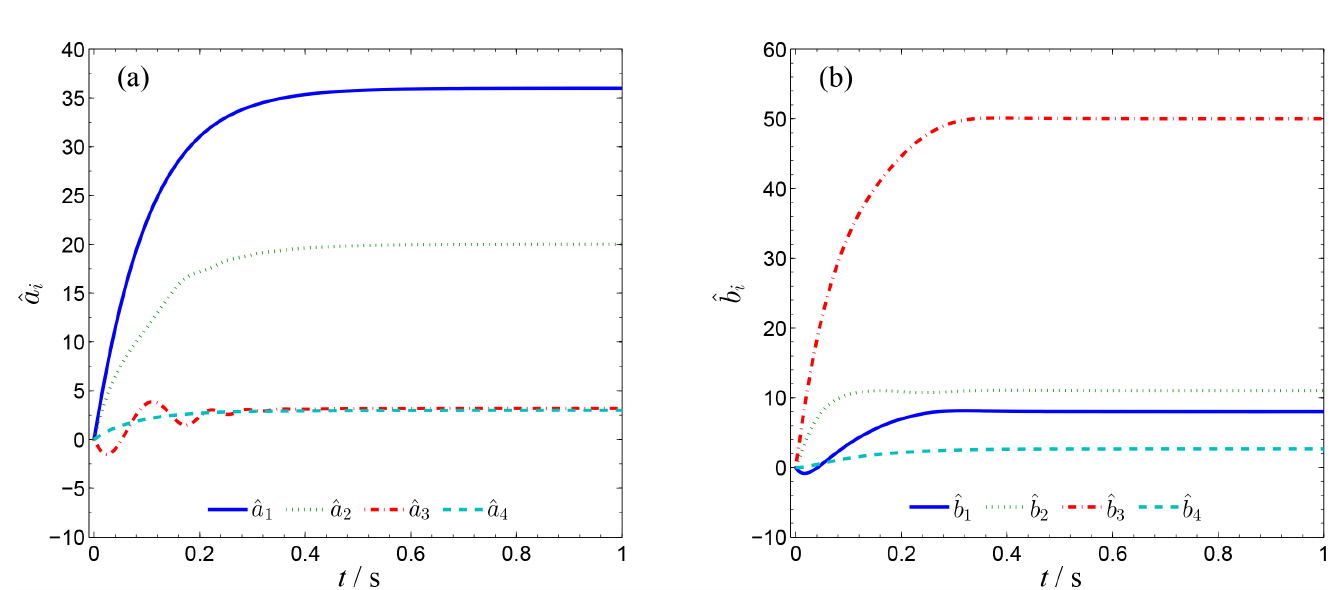
Fig 5. Identification of unknown parameters of systems (12) and (13). (a) ^ a 1 ; ^ a 2 ; ^ a 3 ; ^ a 4 ; (b) ^ b 1 ; ^ b 2 ; ^ b 3 ; ^ b 4 .